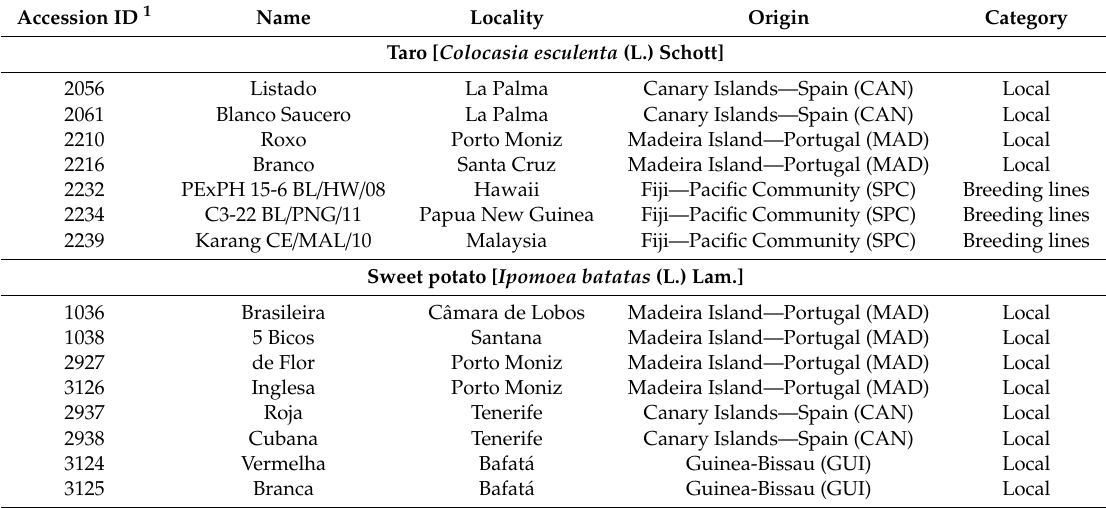
Table 1. Accessions analyzed for quality traits as actual reference (calibration) and near-infrared spectroscopy (NIRS)